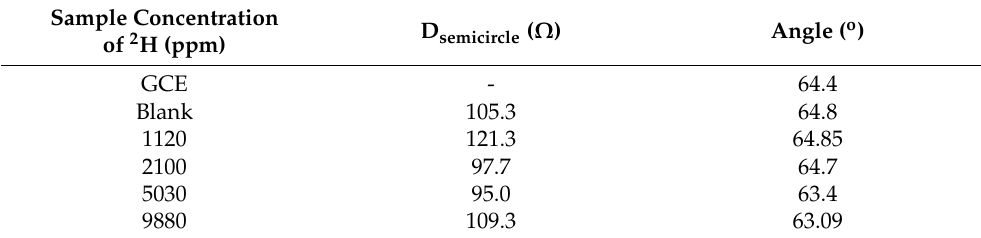
Table 2. The variation in the diameter of the semicircle given by the Faradaic charge transfer process with the concentration of 2 H, resulting from the Nyquist plots.